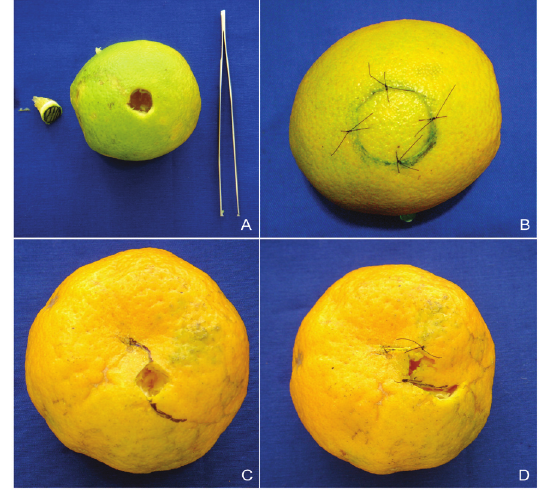
FIGURE 4 – Organic model for the teaching and learning of basic principles of reconstruction. Simulation of a correction of the ( A ) defect formed by placing a ( B ) “skin graft” or by a ( C-D ) “rotation flap”. The stitches were posed only to simulate the final result. It’s just a demonstration on the basic principles of “surgical flaps”, without placement of stitches for coaptation of the “edges”, since for this it is necessary to place tension on the “tissue”, and the model does not show this feature; the rind of the fruit/vegetable lacks the necessary elasticity to withstand this